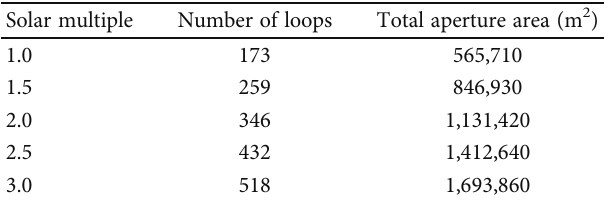
Table 6: Number of loops required for varying solar multiples with design point DNI.